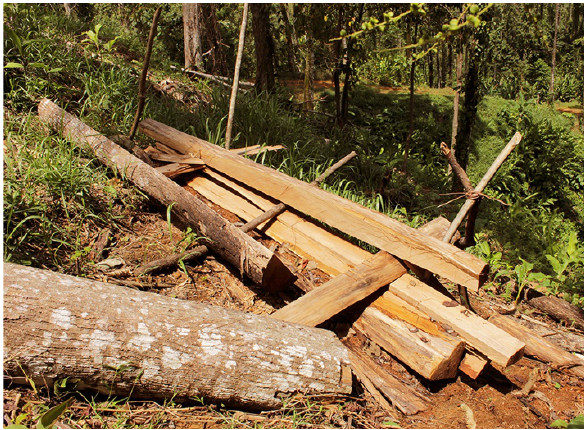
Figure 4. Extraction point near San San river, Naso territory.